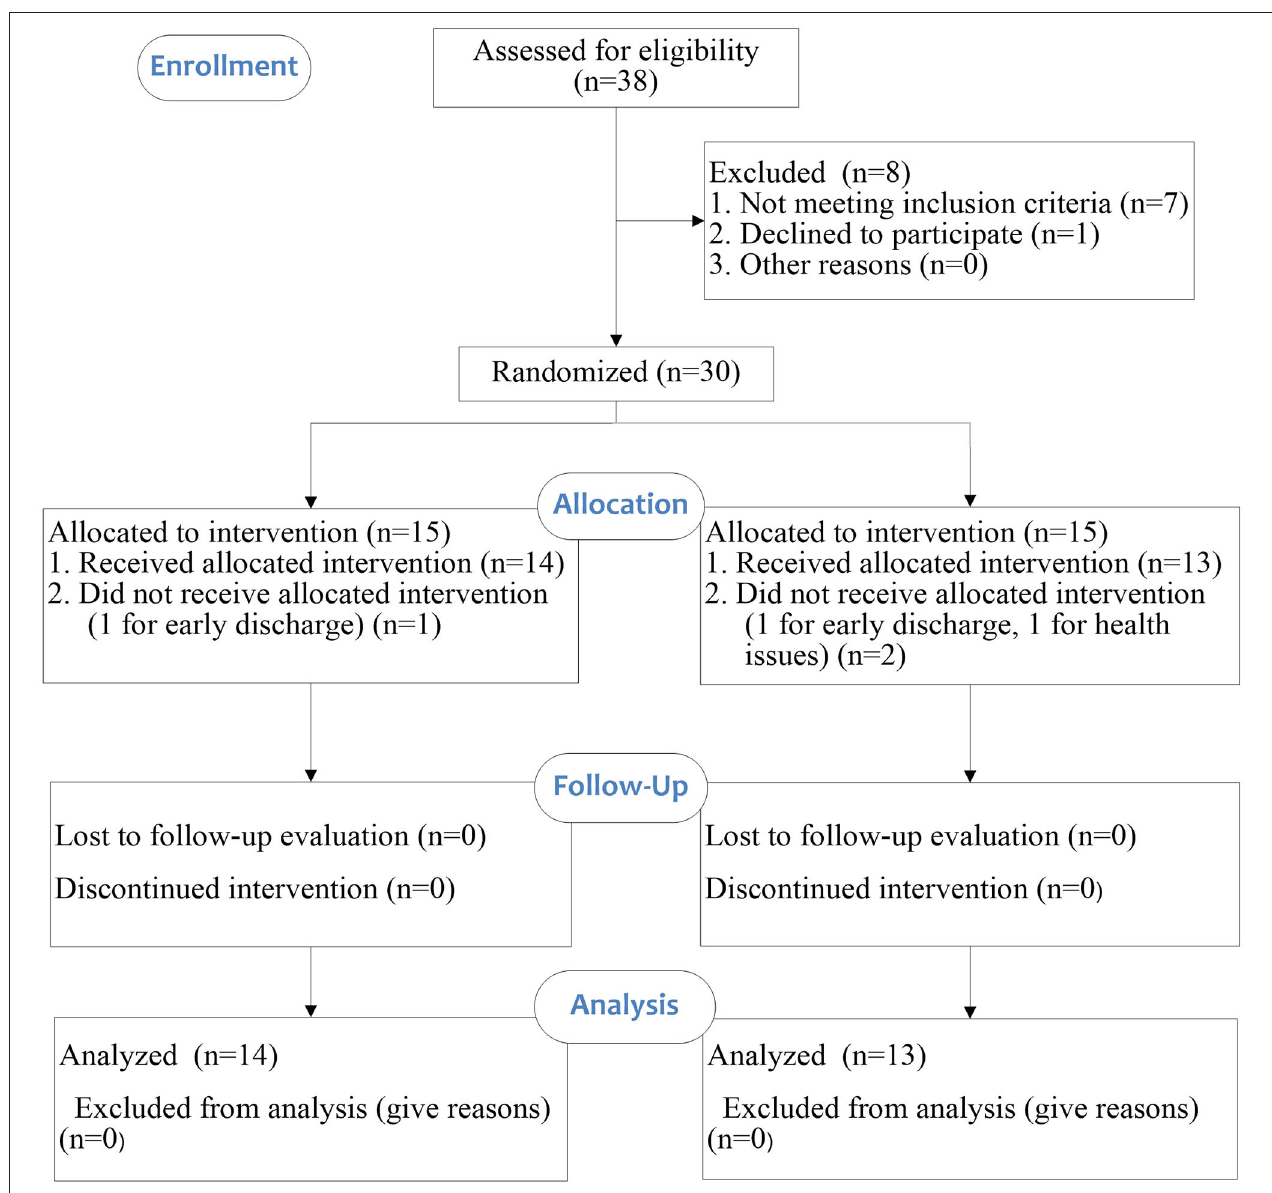
FIGURE 1 | CONSORT flow